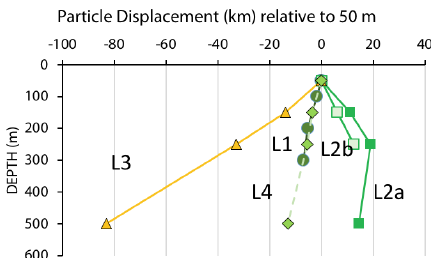
Figure 13. Displacements (in kilometres) in the direction of mo- tion of the filament for particles with a hypothetical sinking rate of 100md − 1 as they sink from 50m. Extreme displacements were cal- culated for transitional waters (L3) where sinking particles lagged behind the surface layer by as much as 85km. Sinking particles would lead the surface layer by 20km at a depth of 250m at L2a. Calculated from ADCP velocities in Fig.